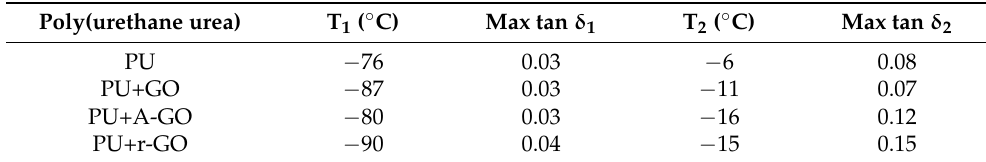
Table 10. Values of the glass transition temperature and the maximum of tan delta of the PUs. DMA experiments.